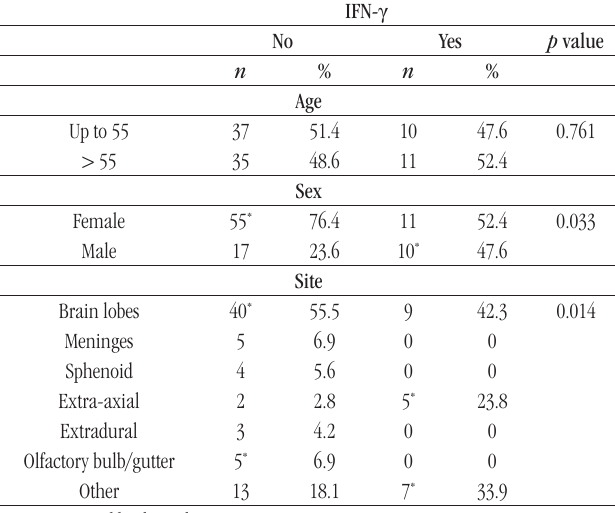
table 1 – Analysis of IFN- γ immunoexpression and its relationship with the clinical variables in patients with meningioma